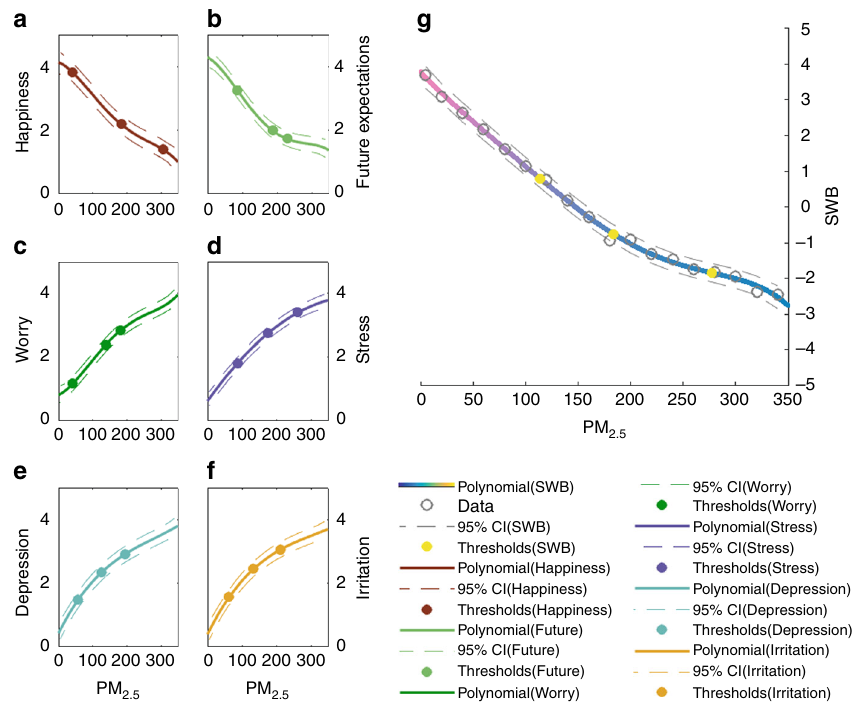
Fig. 1 Polynomial fi tting of air pollutants and perceptual data for all observers. PM 2.5 is selected to represent the increase in air pollution combinations, including PM 2.5 , SO 2 , NO 2 , O 3 and CO. As PM 2.5 increases, the other pollutants increase with fi xed ratios. Solid lines in all sub- fi gures are statistically fi tted lines and dash lines are 95% con fi dence interval lines (CI). a, b The changes in the positive emotions of happiness (dark red) and expectation (light green) with changes in air pollution. c – f The changes in the negative emotions of worry (green), stress (purple), depression (sky blue) and irritation (yellow) with changes in air pollution. g The changes in SWB with changes in air pollution. SWB is in the perceptual range of [ − 5 5]. An SWB of 5 represents the most positive condition (magenta); a SWB of 0 represents a neutral condition (beige); a SWB of − 5 represents the most negative condition (dark brown). See corresponding raw standardized scale value (z-score) data in Supplementary Fig.